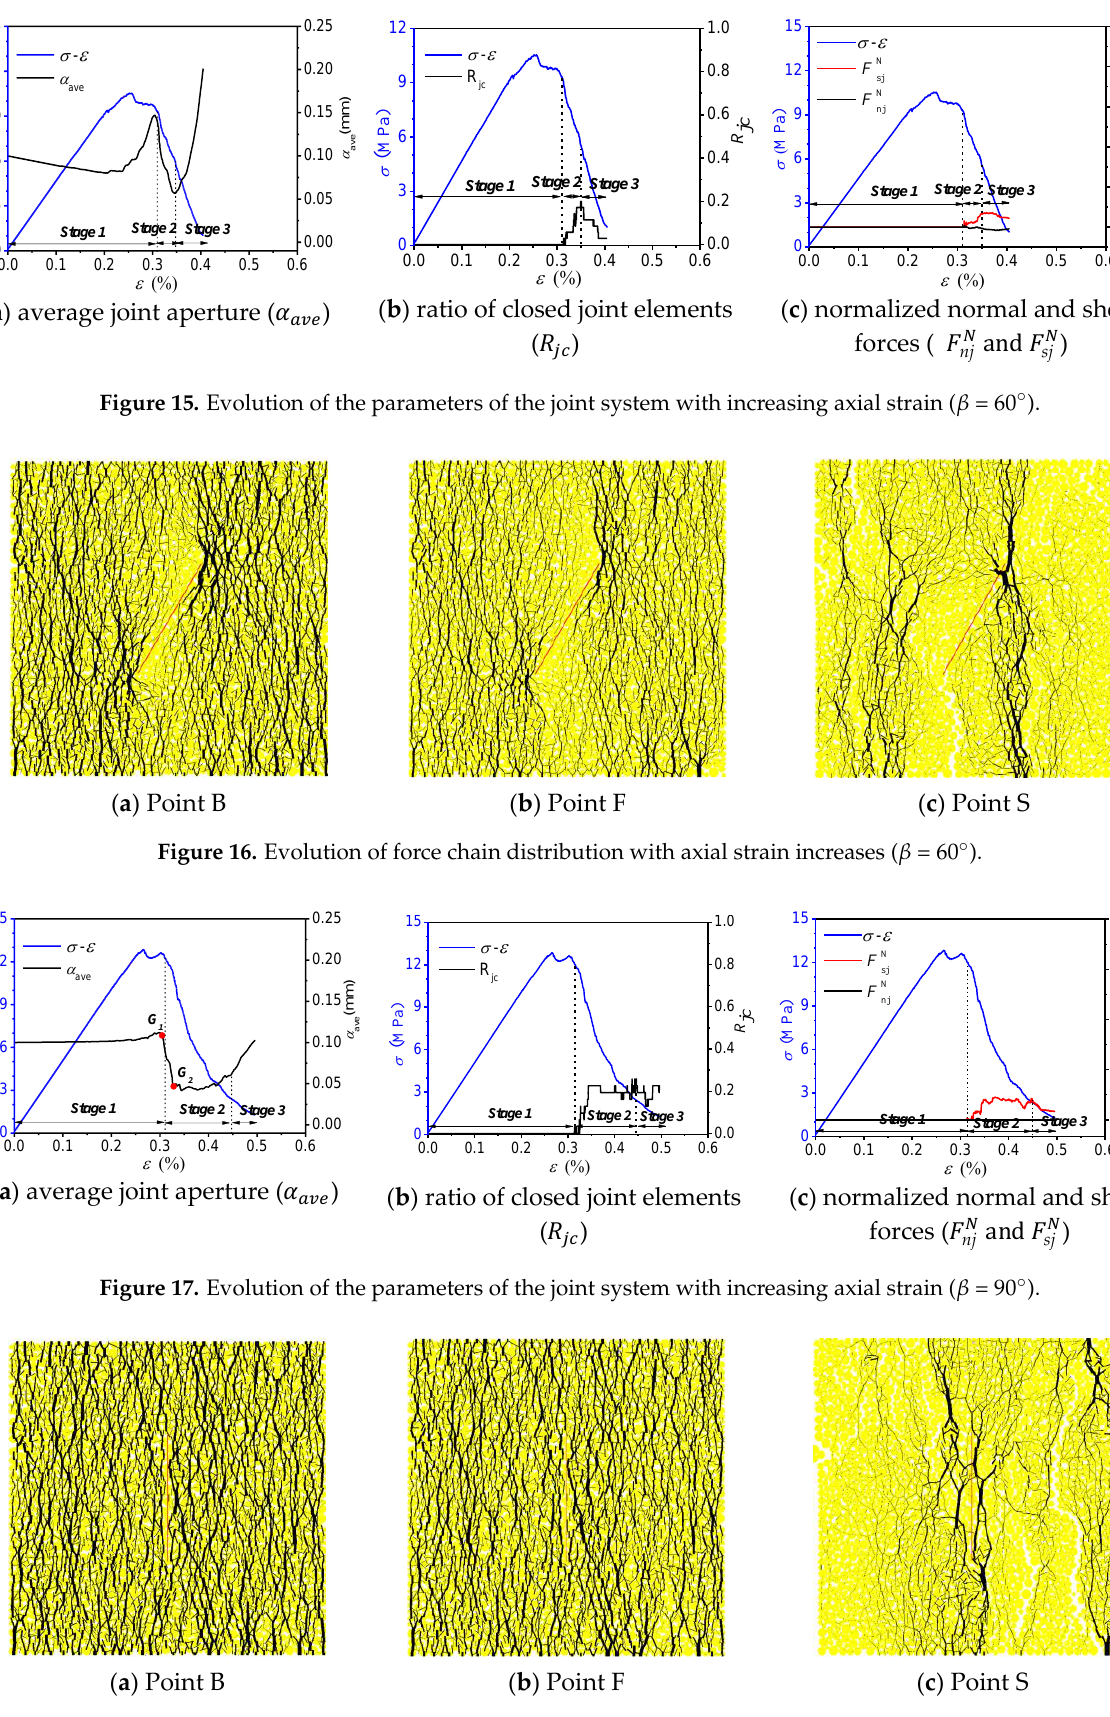
Figure 18. Evolution of force chain distribution with axial strain increases ( 𝛽 = 90°). Stage I: For the specimens with small dip angles ( β = 0° and 30°), the average joint aperture ( 𝑎 𝑎𝑣𝑒 ) decreases rapidly. Based on the force chain distribution at point B (Figures 10a and 12a), the stress concentration at the joint tips and the stress arches in the matrix can be found. For β = 0°, this stage almost coincided with the elastic deformation stage of the stress–strain curve; however, for β = 30°, this stage coincided with the pre-peak stage of the stress–strain curve. For the specimens with medium inclination angles ( β = 45°and 60°), in the early part of this stage, which coincided with the pre-peak stage of the stress– strain curve, the decrease in speed was obviously smaller than that of the specimens with small inclination angles. Based on the force chain distribution at points B and F (Figures 14a,b and 16a,b), the stress concentration appears at the joint tips, and the stress in the matrix gradually transitions from a uniform distribution to localization. In the later part of this stage, which coincided with the yield stage on the post-peak portion of the stress– strain curve, 𝑎 𝑎𝑣𝑒 increased rapidly, which may be caused by the dilation. For β = 45°, 𝑎 𝑎𝑣𝑒 increased rapidly and then decreased instantaneously. Figure 19a–c show the break- age distribution of the contact bonds in the matrix of the specimen at 𝐺 1 and 𝐺 2 , and the variation trends of 𝑎 𝑎𝑣𝑒 and the number of crack elements over the axial strain. It was found that at 𝐺 1 and 𝐺 2 , the AE activity was very strong, and the connection between the joint tips and macrocracks formed by the initiation, propagation, and coalescence of the microcracks lead to joint sliding, and thus, 𝑎 𝑎𝑣𝑒 decreased sharply. For the high joint an- gle specimens, 𝑎 𝑎𝑣𝑒 did not significantly decrease in this stage, and the stress distribution in the matrix was uniform (Figure 18a,b). For all of the jointed specimens, 𝑅 𝑗𝑐 , 𝐹 nj 𝑁 , and 𝐹 sj 𝑁 remained at zero, indicating that the joint elements were closing, but none of them had fully closed yet in this stage, and they could not transfer any of the normal or shear forces. Stage II: For all of the jointed specimens, 𝑎 𝑎𝑣𝑒 reached its minimum in this stage. For the jointed specimens with β = 60° and 90°, 𝑎 𝑎𝑣𝑒 instantaneously decreased. The reason